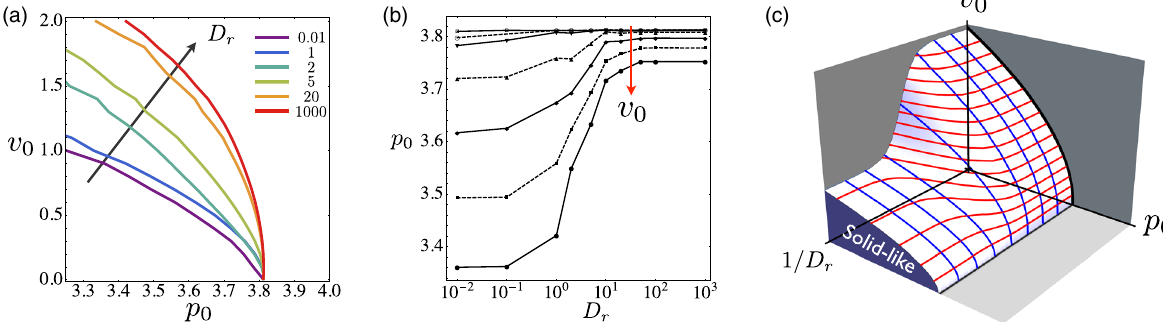
FIG. 3. (a) The glass transition in v 0 − p 0 phase space shifts as the persistence time changes. Lines represent the glass transition identified by the structural order parameter q ¼ 3 . 81 . The phase boundary collapse to a single point at p (cid:3) 0 ¼ 3 . 81 , regardless of D limit v 0 → 0 . (b) The glass transition in p 0 − D 0.26). For large v 0 there is a crossover in the behavior at D between solid and fluid as a function of motility v 0 , persistence 1 =D a schematic 3D phase diagram. Red lines on the surface correspond to iso- v 0 contours and blue lines correspond to iso- D